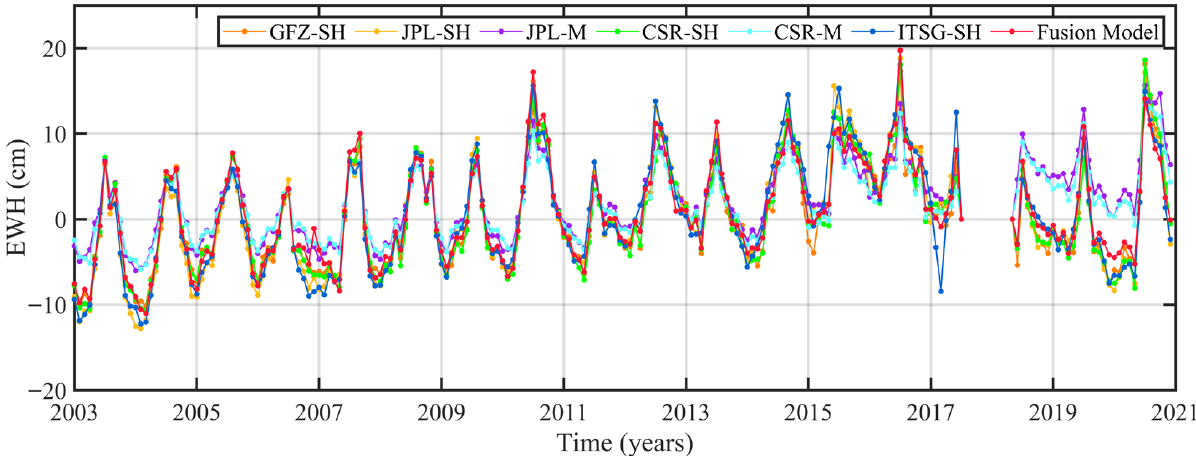
Figure 4. The time series of TWSC derived from six GRACE solutions and fused result in the YRB.